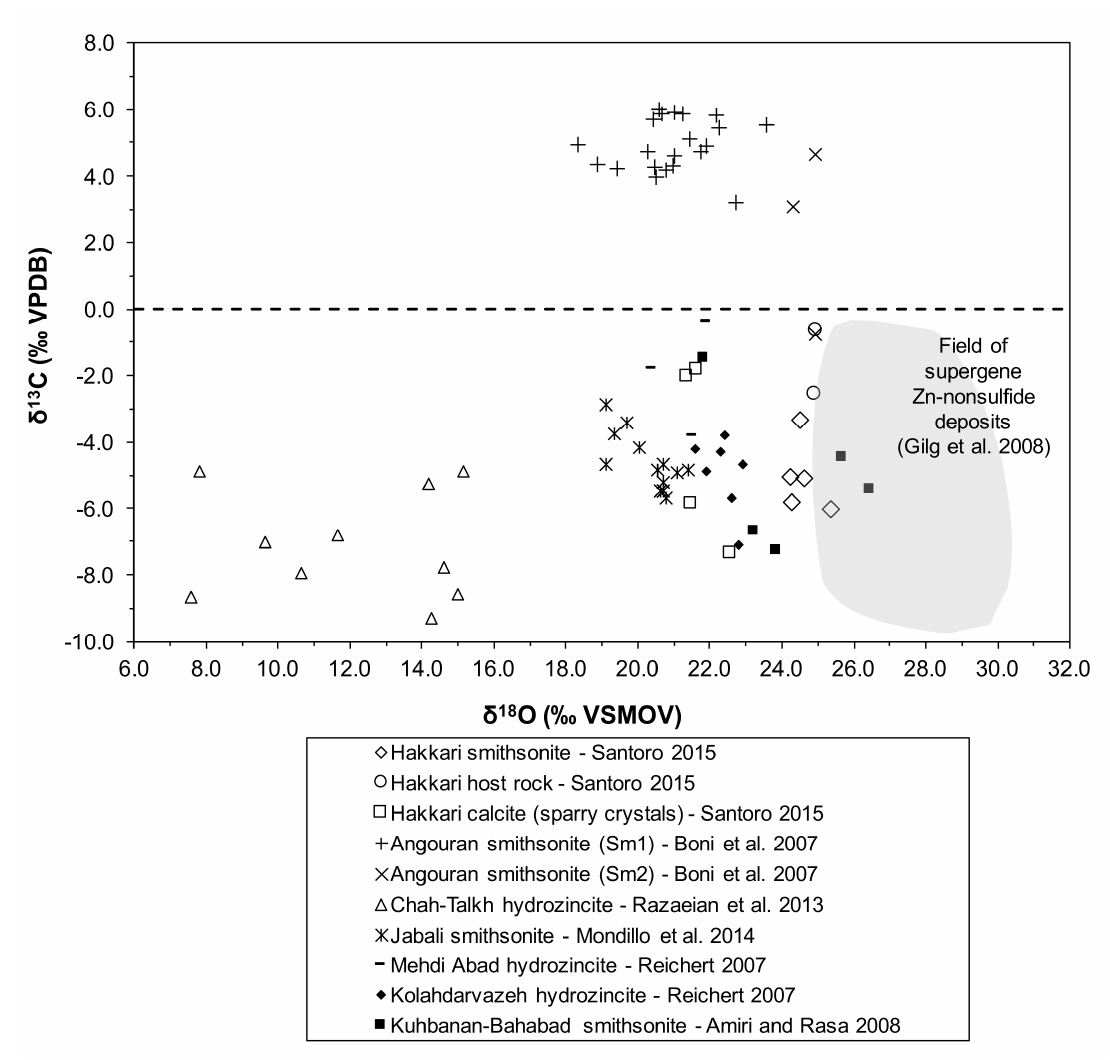
Figure 2. Carbon and oxygen isotope values of smithsonite, hydrozincite, and calcite from several occurrences in the Middle East.